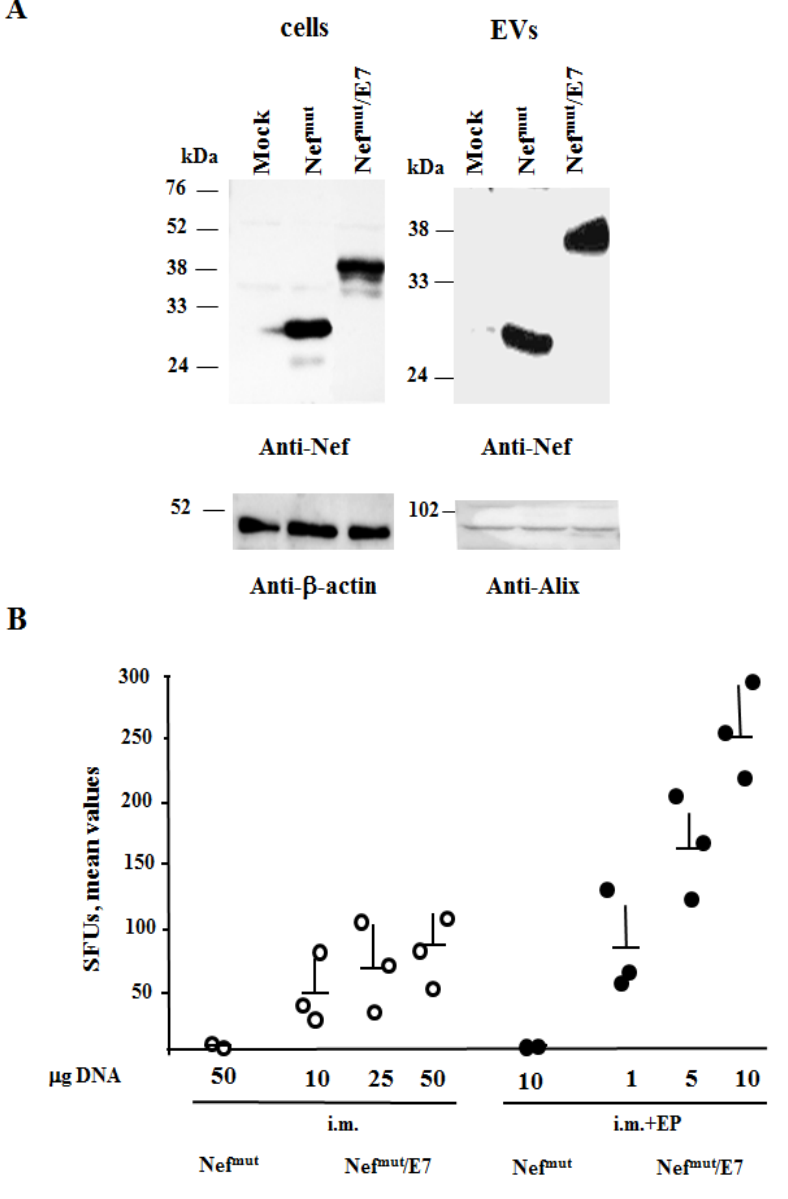
Figure 1. EP increases the antigen-specific CD8 + T cell response triggered by injection of Nef mut /E7 vector. ( A ) Detection of Nef mut /E7 in HEK293T transfected cells and EVs. Western blot analysis of 30 μ g of lysates from cells transfected with DNA vectors expressing Nef mut /E7, and equal volumes of buffer where purified EVs were resuspended after differential centrifugations of the respective supernatants. As control, conditions from mock-transfected cells as well as cells transfected with Nef mut were included. Polyclonal anti-Nef Abs served to detect Nef mut -based products, while β -actin and Alix were markers for cell lysates and EVs, respectively. Molecular markers are given in kDa. The results are representative of six independent experiments. ( B ) C57BL/6 mice (three per group) were injected i.m. with the indicated μg of DNA vectors expressing either Nef mut or Nef mut /E7 followed or not by EP treatment. Treatments were repeated 14 days later, and after additional 14 days, splenocytes (2.5 × 10 5 /well) were tested in IFN- γ EliSpot assay for the presence of E7-specific CD8 + T lymphocytes. For each mouse, shown are the numbers of IFN- γ spot-forming units (SFUs) as mean values of triplicates after subtraction of values from wells treated with unrelated peptides.